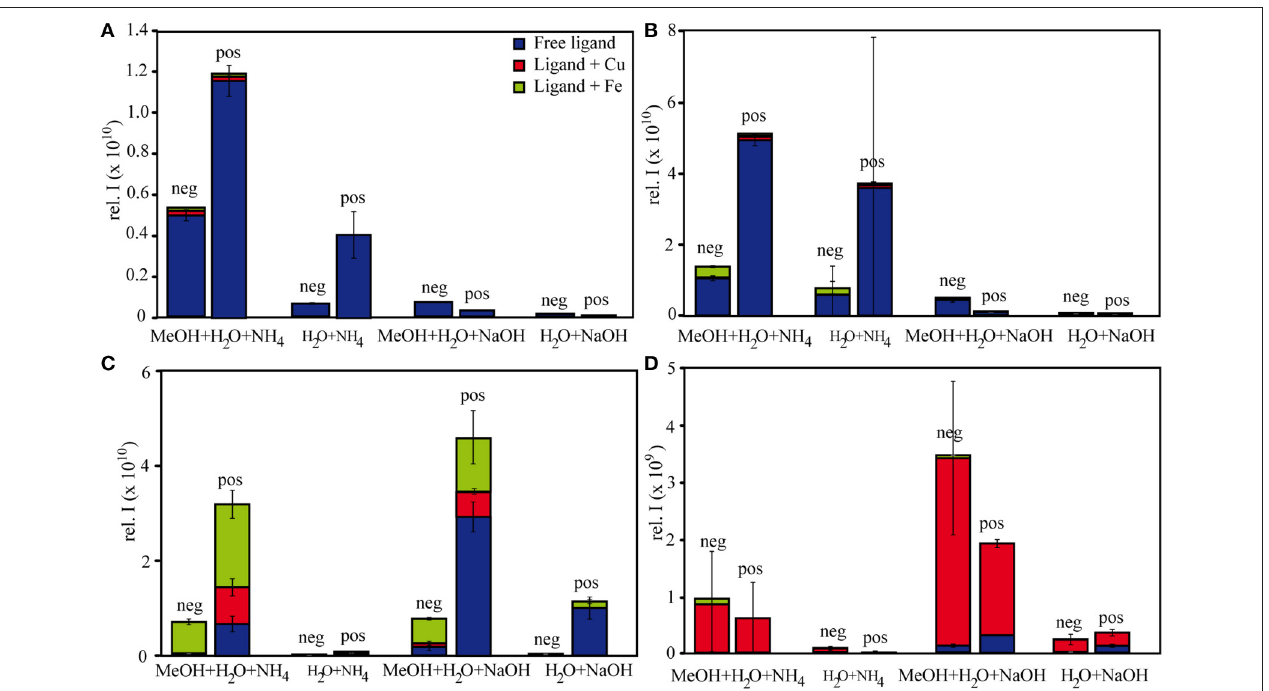
FIGURE 1 | Relative intensities of free and complexed (A) citrate, (B) EDTA, (C) NN, and (D) SA under different measurement settings. The relative intensities of each of the subgroups (free ligand, Fe-ligand, Cu-ligand) are calculated as the sum of all intensities of the detected species in the subgroup.